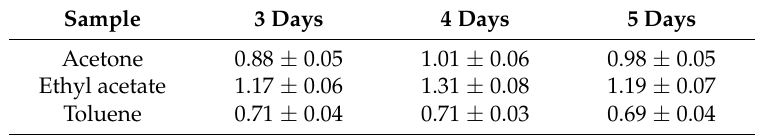
Table 4. Equilibrium adsorption capacities (mmol/g) of Dt/S-1 (5 wt%) prepared at different